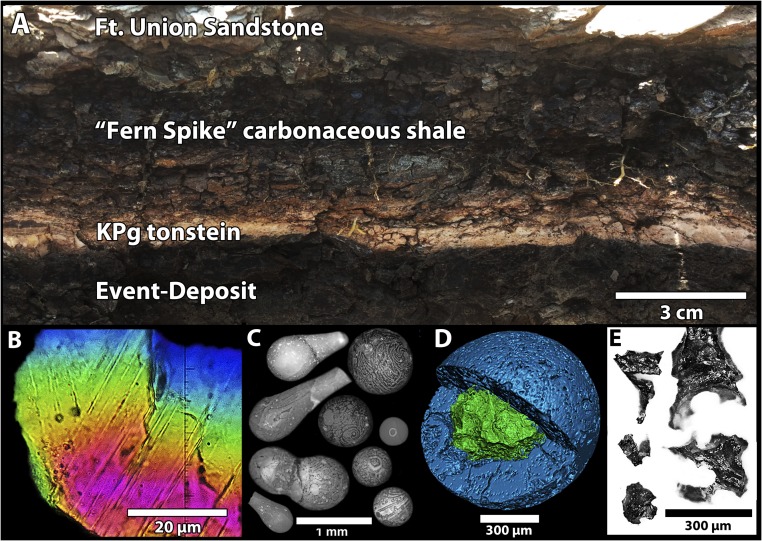
Chicxulub tonstein capping the Event Deposit at Tanis and representative impact-derived materials. (A) Iridium-enriched tonstein in situ atop the Event Deposit. (B) Shocked mineral with multiple intersecting planar deformation features (FAU.DGS.ND.161.977.T). (C) Clay-altered ejecta spherules (FAU.DGS.ND.161.33.T), some with prominent schlieren. (D) Micro-CT of a clay-altered ejecta spherule with unaltered glass core (FAU.DGS.ND.161.11.T). (E) Shards of unaltered impact glass (FAU.DGS.ND.161.45.T).